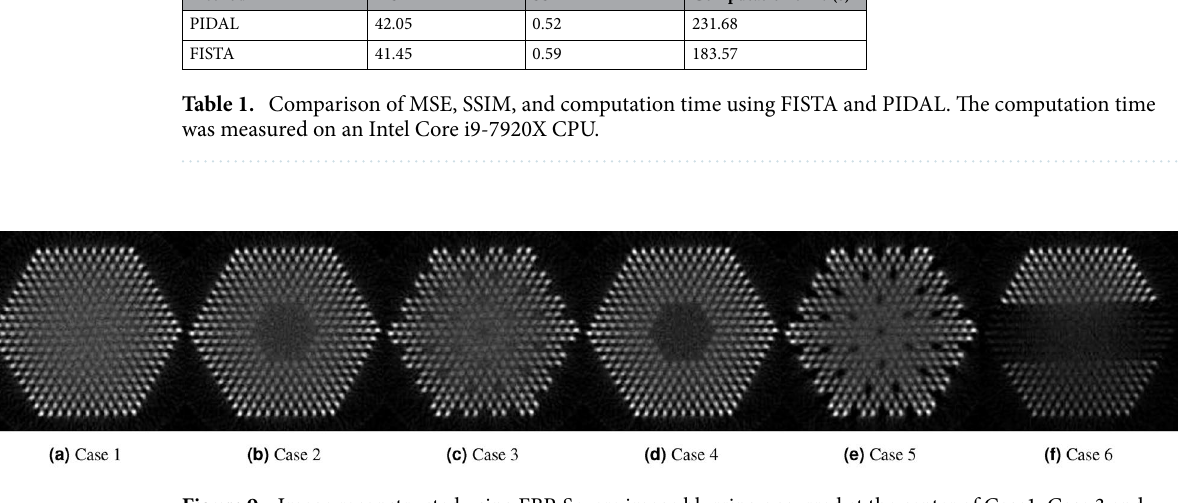
Figure 9. Image reconstructed using FBP. Severe image blurring occurred at the center of Case1, Case 3 and Case 5.